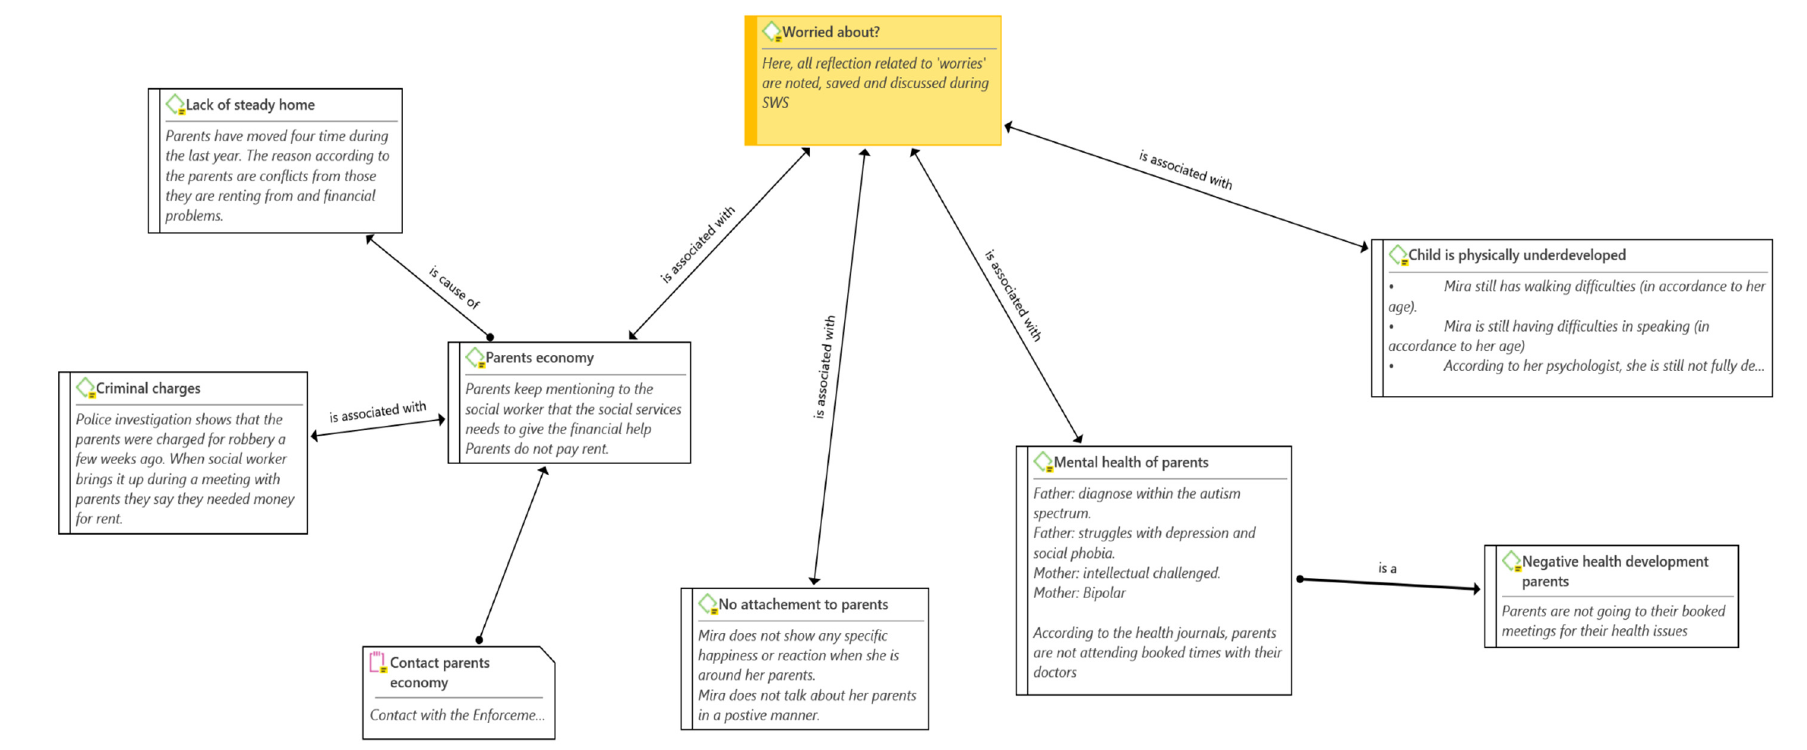
Figure 3 . Example of a network with codes, notes, and links. Figure 3. Example of a network with codes, notes, and